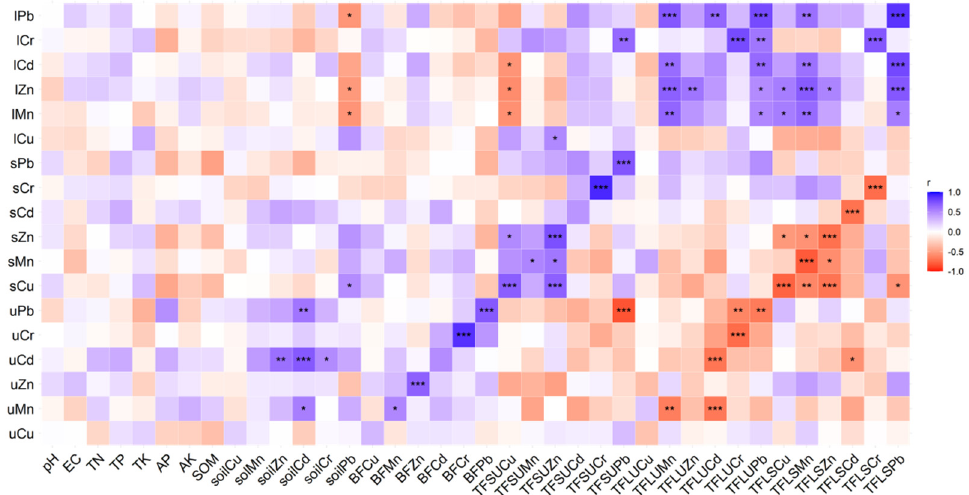
Figure 4. Pearson’s coefficient analysis of heavy metal concentrations in different plant organs, soil chemical properties and heavy metal absorption-translocation capability. The first letters of the vertical axis indicate: ‘l’ represent plant leaves, ‘s’ indicates stems and ‘u’ for underground organs followed by the chemical symbol of each heavy metal. In the horizontal axis, pH—soil pH; EC—soil electrical conductivity; TN—soil total nitrogen; TP—soil total phosphorous; TK—soil total potassium; AP—soil available phosphorous; AK—soil available potassium; SOM—soil organic matter. Moreover, the indicators of “BF + heavy metal chemical symbol” represent the bioaccumulation factor of the corresponding heavy metal. TFSUCu, TFSUMn, TFSUZn, TFSUCd, TFSUCr and TFSUPb represent translocation factor for Cu, Mn, Zn, Cd, Cr and Pb from underground organs to stems, respectively. It is same for TFLUCu, TFLUMn, TFLUZn, TFLUCd, TFLUCr, TFLUPb, TFLSCu, TFLSMn, TFLSZn, TFLSCd, TFLSCr and TFLSPb, where LU and LS represent translocation from the underground organs to leaves, and stems to leaves, respectively. Asterisks indicate significance: * p < 0.05, ** p < 0.01, *** p < 0.001.